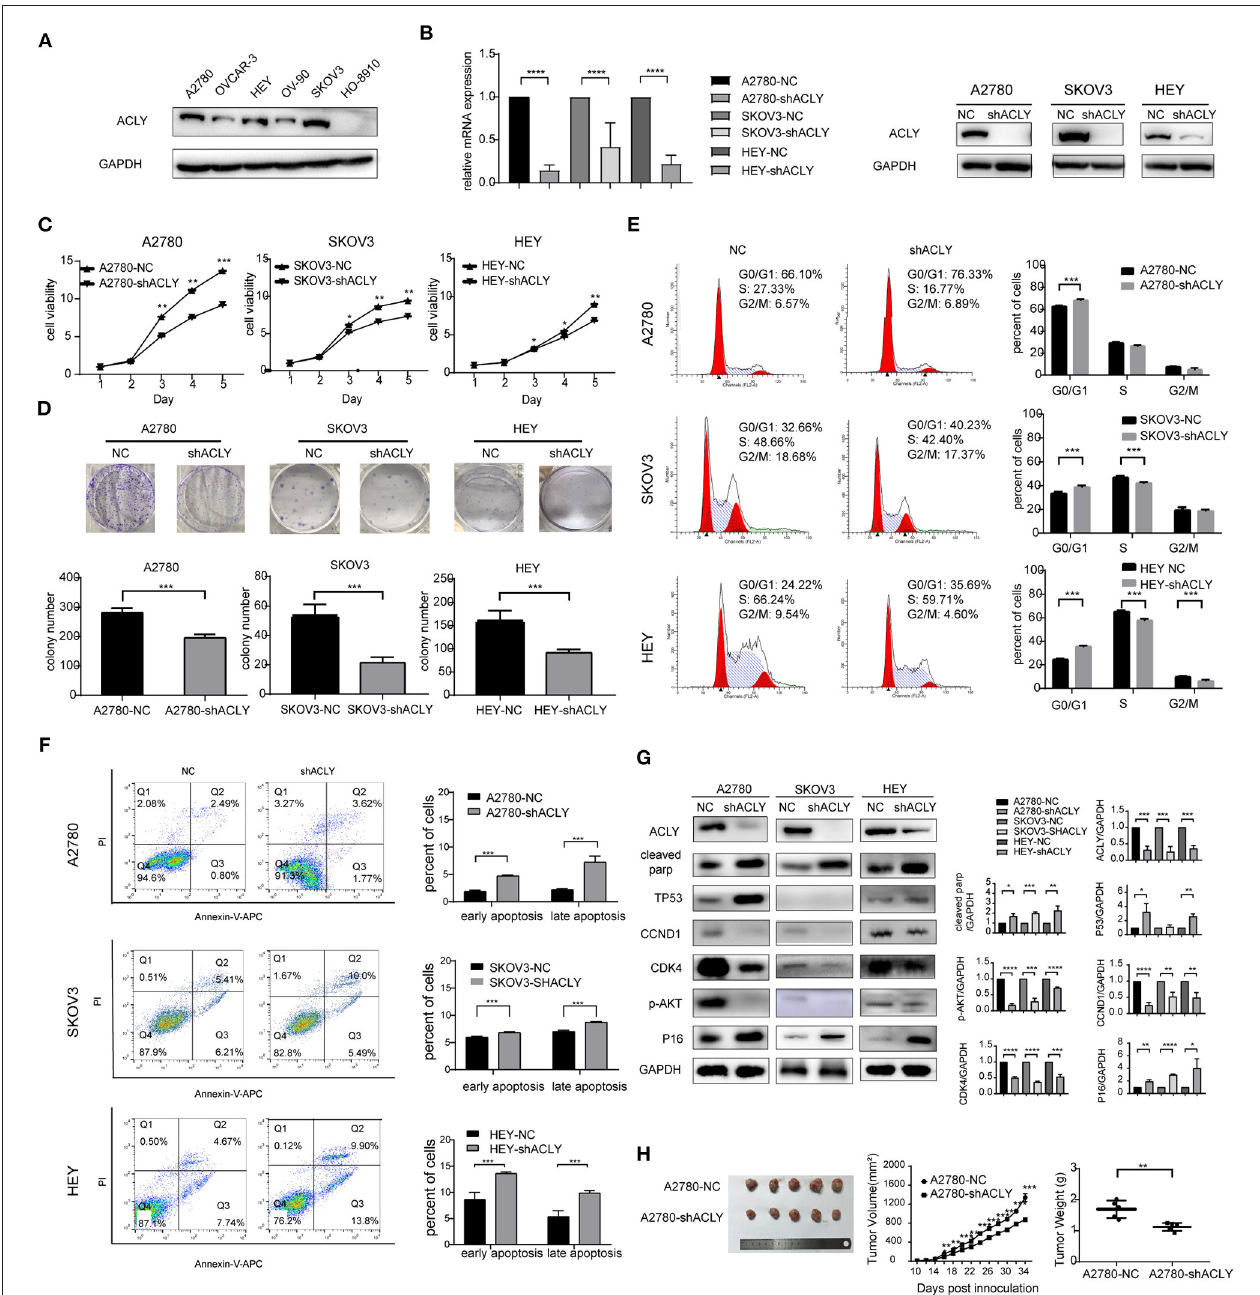
FIGURE 2 | ACLY knockdown inhibited ovarian cancer progression in vitro and in vivo . (A) Western blotting was used to detect the expression of ACLY in several ovarian cancer cell lines. (B) PCR and Western blotting was used to confirm the effectiveness of ACLY knockdown by lentivirus in A2780, SKOV3, and HEY cells, the relative mRNA levels were analyzed using Student’s t -test. (C) MTT assays were used to detect the proliferative activity change on the knockdown of ACLY in A2780, SKOV3, and HEY cells, the growth curves were analyzed using one-way ANOVA test. (D) Colony formation assays of ACLY knockdown and its corresponding NC cells of A2780, SKOV3, and HEY, colony numbers were counted and analyzed using Student’s t -test. (E) Cell cycle of A2780, SKOV3, and HEY with ACLY knockdown cells and their corresponding NC cells by flowcytometry, the difference of cell cycle distribution between groups was analyzed using student t -test. (F) Annexin-V apoptosis assays and flowcytometry were used in ACLY knockdown and its corresponding NC cells of A2780, SKOV3, and HEY, quantitive analysis of apoptotic ratio by flowjo V10 software. Statistical analysis was performed using Student’s t -test. (G) Western blotting images, quantitation, and statistical analysis of the western blotting bands in the aforementioned cells to detect the expression of cell cycle checkpoints (CCND1, CDK4), their upstream regulators (P16, P53), marker of apoptosis (cleaved parp), and p-AKT. The bands were quantitated with Image J software, statistical analysis was performed using Student’s t